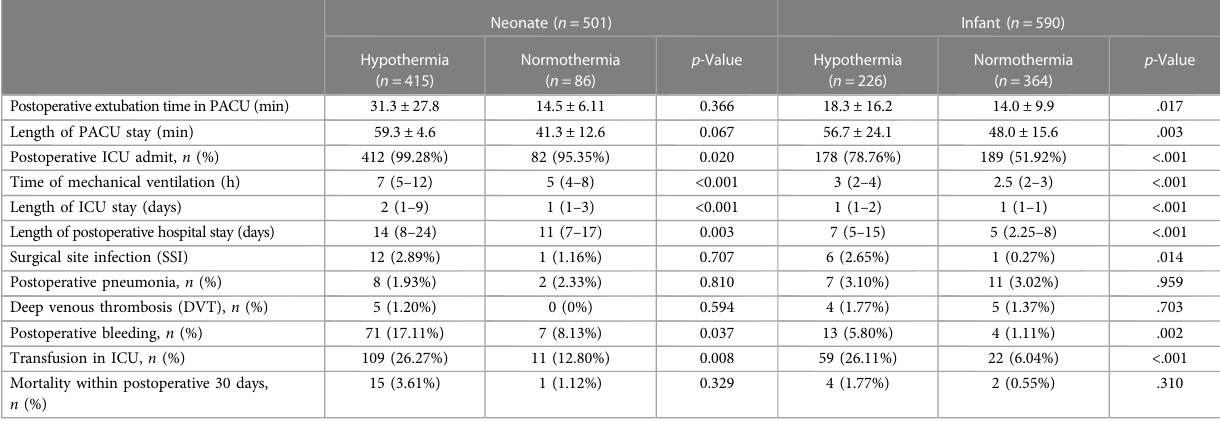
TABLE 2 Outcomes of hypothermia and